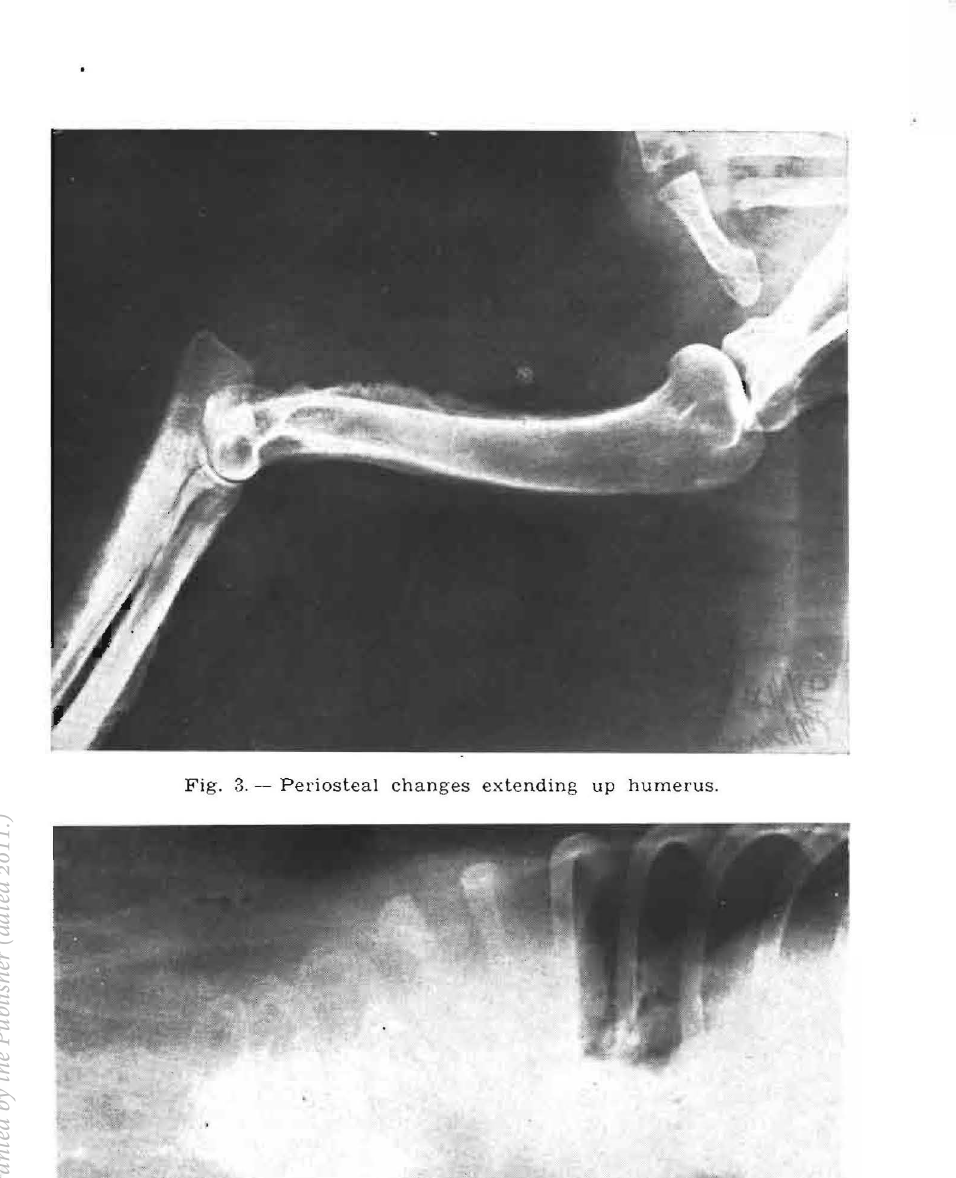
Fig. 4. - Tumour of the thoracic